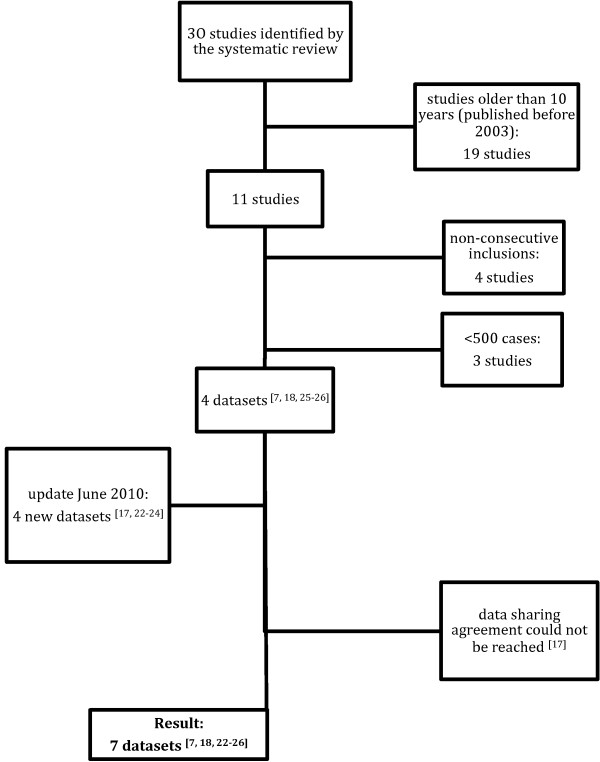
Flowchart of dataset inclusion.